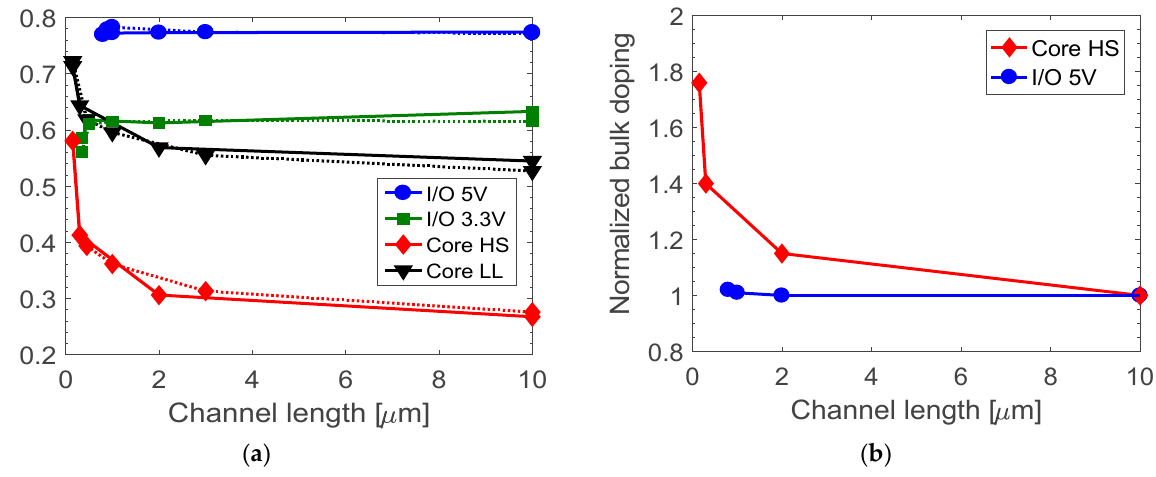
Figure 2. ( a ) Threshold voltage V th as a function of the channel length for fresh nMOSFETs. Con- tinuous lines refer to narrow transistors with W = 0.8 µ m for I/O devices and W = 0.3 µ m for core ones. Dotted lines refer to large transistors with W = 10 µ m for I/O and core devices. Measurements carried out at room temperature in linear region ( V ds = 0.1 V). ( b ) Normalized bulk doping at the center of the channel as a function of the channel length of core HS and I/O 5V nMOSFETs. The bulk doping value is normalized by the bulk doping of the longest device ( W = 10 µ